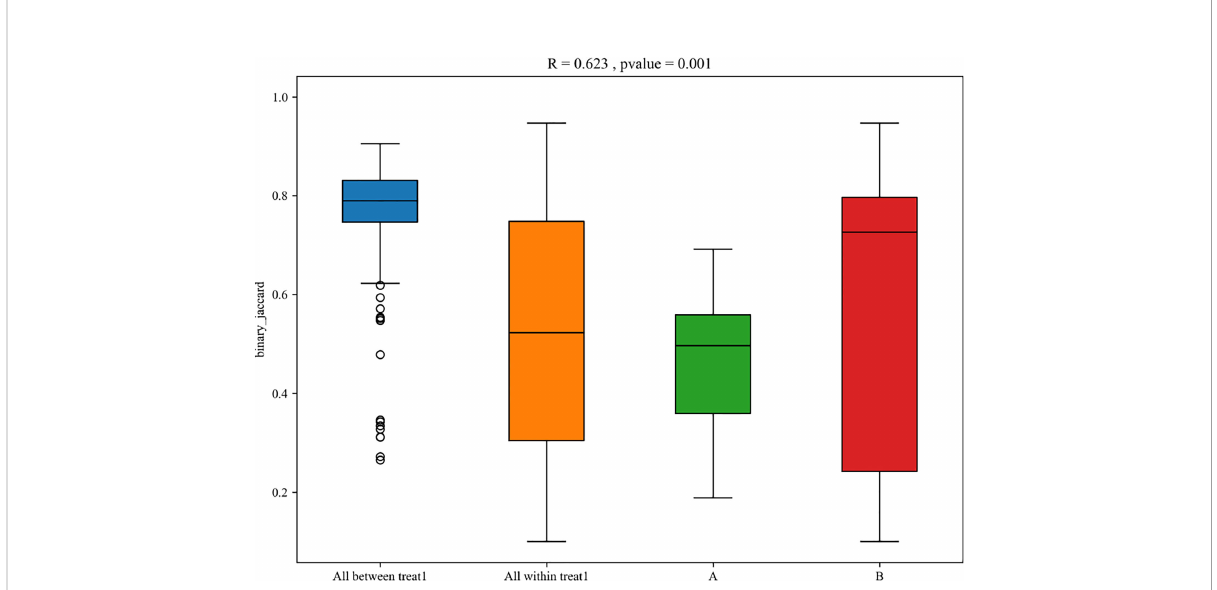
FIGURE 7 Box plot of PERMANOVA between samples of LRTI children with/without hematological malignancies. A mean BALF samples ofLRTI children with hematological malignancies; B mean BALF samples of LRTI children without hematological malignancies. Treat 1 means the differences(the basis of maignancies and the correlated conditions) between the two